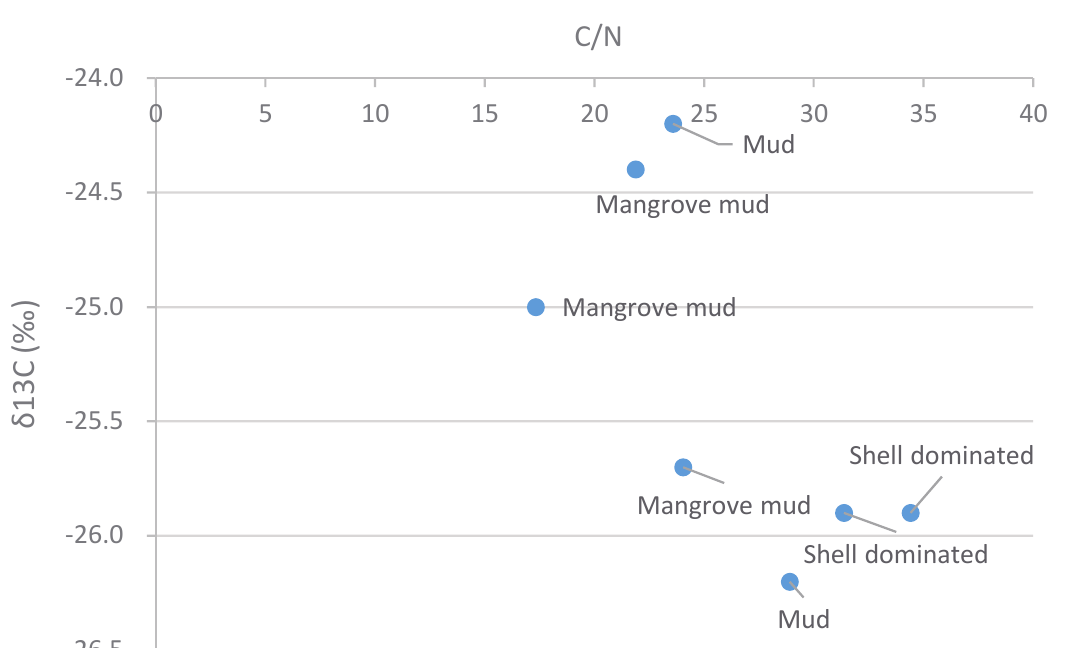
Figure 9. δ 13C values and C/N values of soils and sediments in the